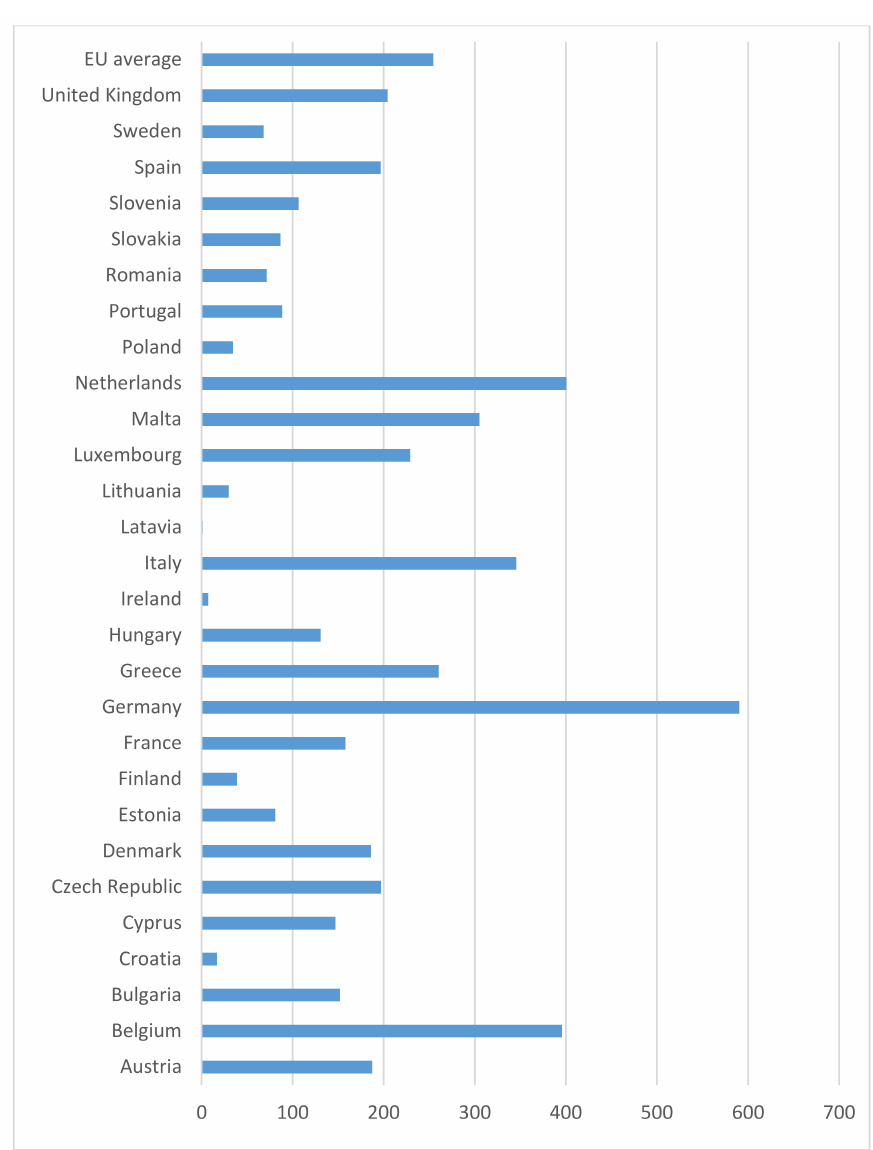
Figure 1. Photovoltaic capacity additions in the European Union countries in 2019 (MW). Source: Own analyses based on data: